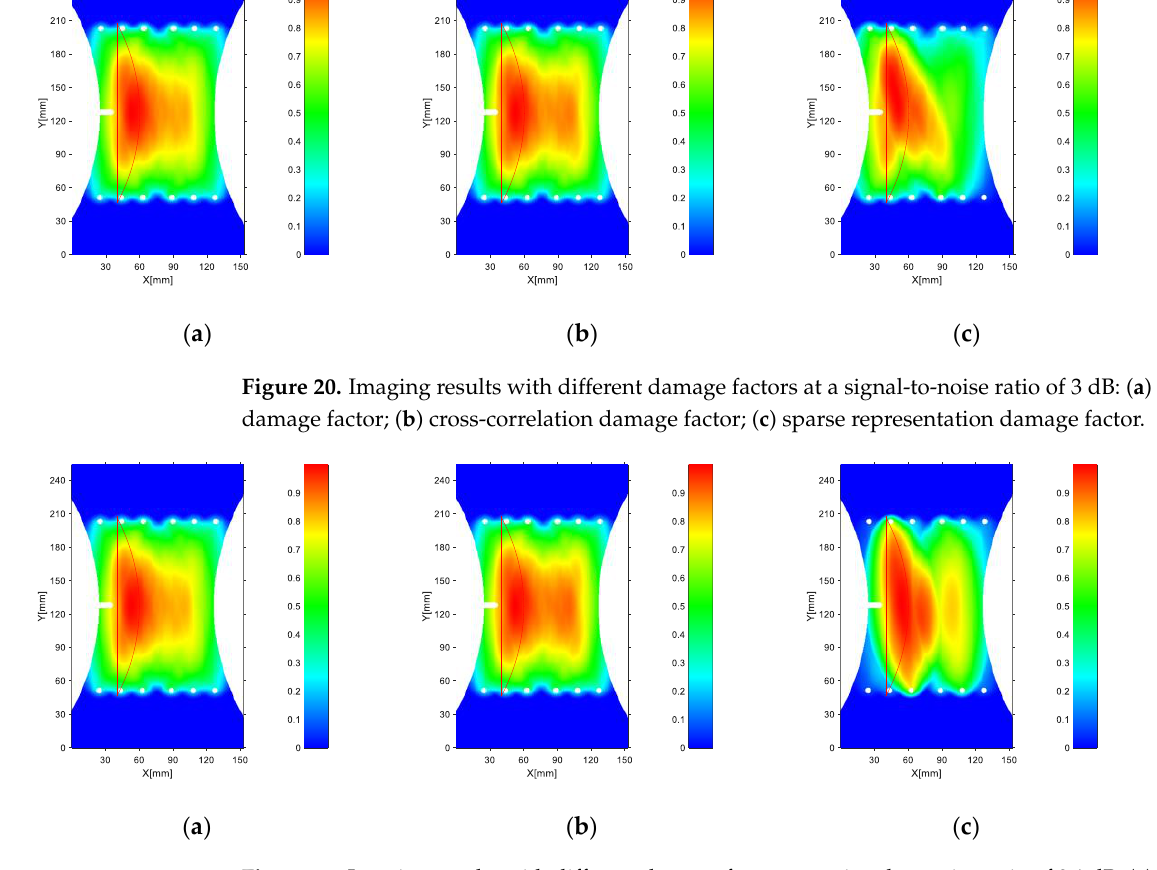
( c ) Figure 22. Thresholded imaging with different damage factors at a signal-to-noise ratio of 6 dB: ( a ) energy damage factor; ( b ) cross-correlation damage factor; ( c ) sparse representation damage factor. ( a ) ( b ) ( c ) Figure 23. Thresholded imaging with different damage factors at a signal-to-noise ratio of 3 dB: ( a ) energy damage factor; ( b ) cross-correlation damage factor; ( c ) sparse representation damage factor.